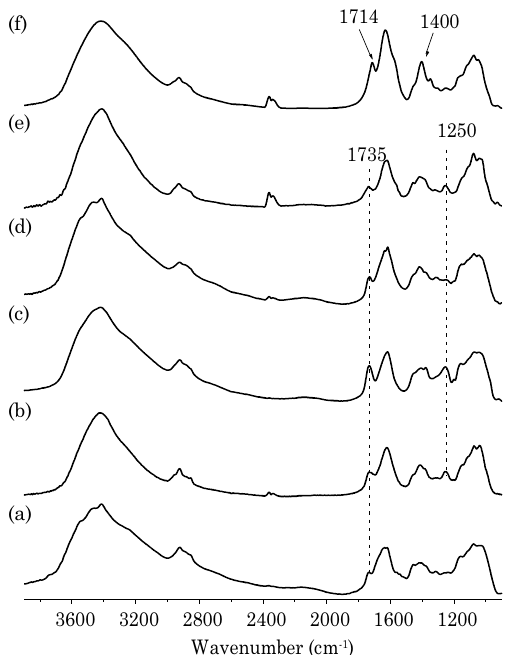
figure 4. infrared spectrum of the exopolysaccharides produced by (a) Rhizobium giardini bv. giardini h152 t , (b) Mesorhizobium loti lMG6125, (c) Mesorhizobium plurifarium lMG11892, (d) Sinorhizobium (= Ensifer ) kostiense lMG19227, (e) Mesorhizobium huakuii lMG14107, and (f) Rhizobium mongolense